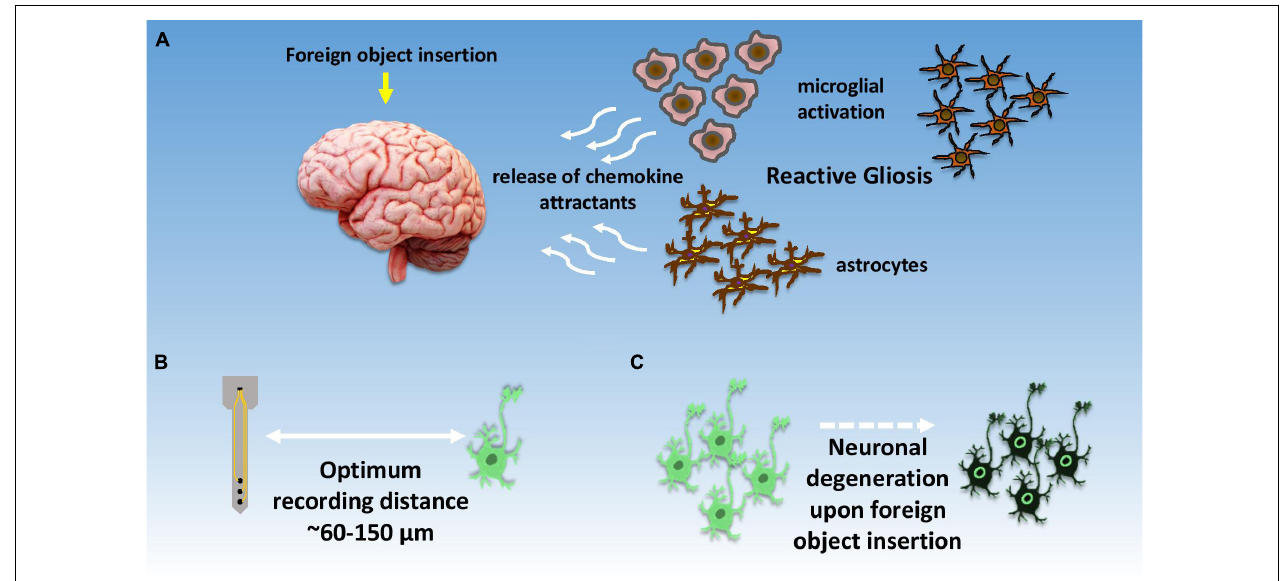
FIGURE 4 | Illustrative summary of neuronal response toward signal recordings. (A) Depiction of foreign body response within the brain and initiation of reactive gliosis due to local brain inflammation; (B) optimal distance for recording neuronal spikes with high signal to noise ratio, (C) localized neuronal degradation after electrode insertion within brain